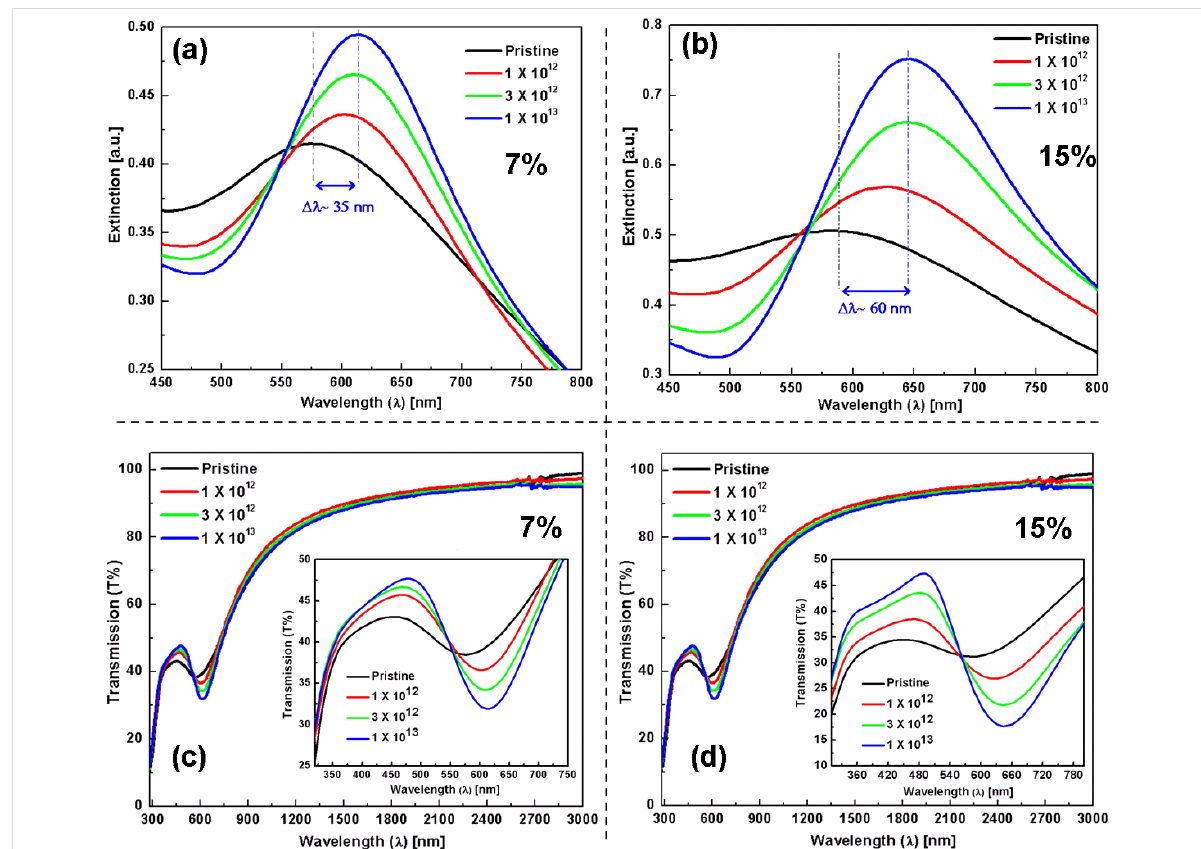
Figure 6: UV–visible absorption and transmission spectra of Au–TiO 2 nanocomposite films (with an MVF of about 7% and 15%, respectively) at different ion beam fluences (1 × 10 12 , 3 × 10 12 and 1 × 10 13 ions/cm 2 ). (a,b) Variations in SPR absorption as a function of the ion beam fluence. (c,d) Transmission spectra of Au–TiO 2 nanocomposite films (corresponding to a and b) as a function of the ion beam fluence. The inset images (in c and d) show the magnified views from band-edge